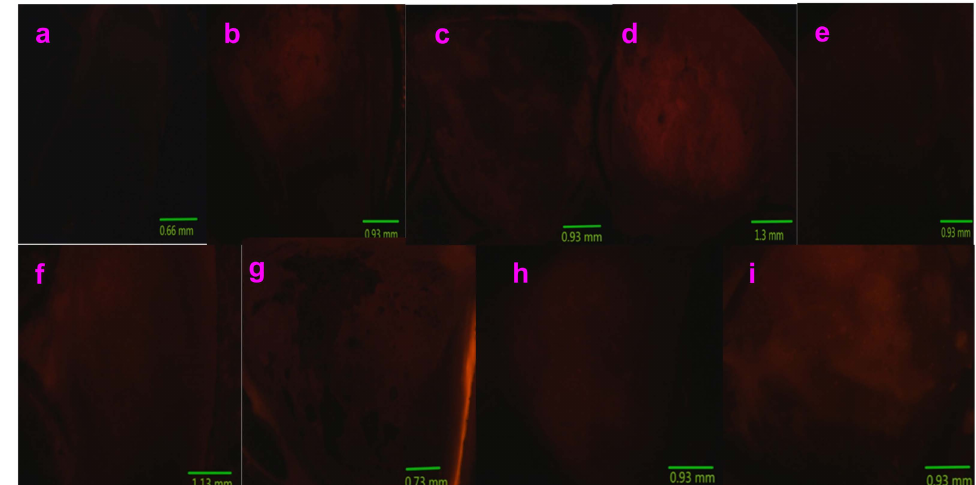
Figure 10. Fluorescence images of pig kidney coated with Sm–Me (Me = Fe, Ga, Mn, Na, Nb, W, Cu, and Al) nanoparticles are generated when blue-light excitation (540–552 nm) is used: ( a ) Control (no nanoparticles are used); ( b ) Sm–Fe; ( c )Sm–Ga; ( d ) Sm–Mn; ( e ) Sm–Na; ( f ) Sm–Nb; ( g ) Sm–W; ( h ) Sm–Cu; ( i ) Sm–Al.